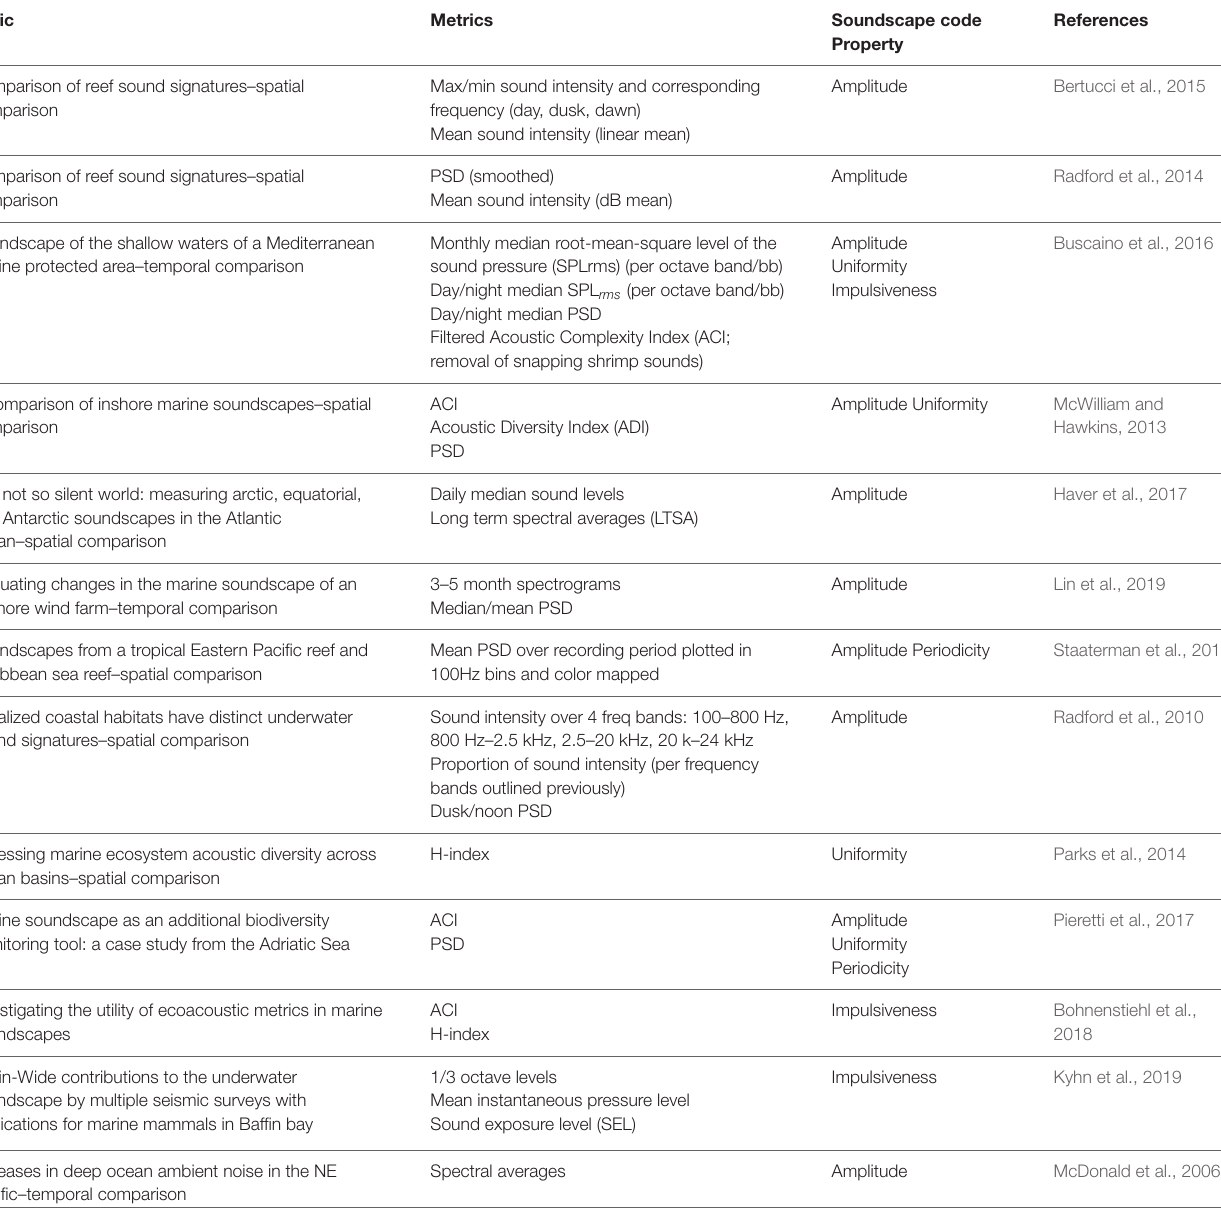
TABLE 1 | Literature selected to emphasize how authors implement a variety of acoustic